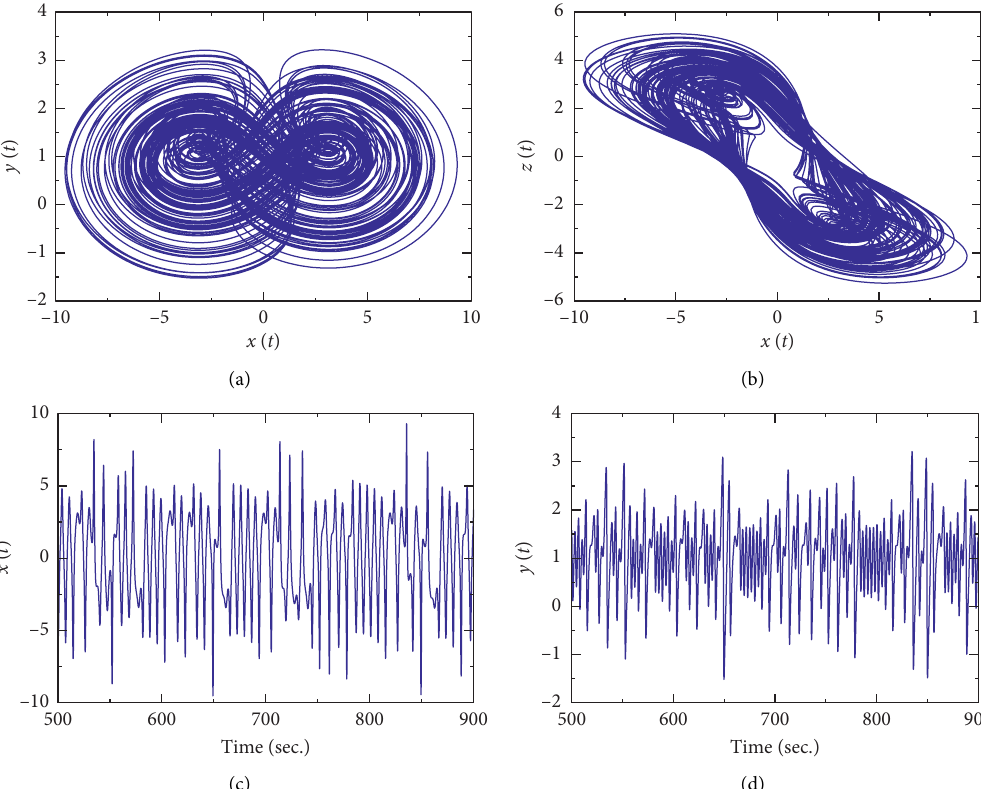
Figure 1: Phase diagrams and time series of system (5). (a) Projected onto the x − y phase plane. (b) Projected onto the x − z phase plane. (c) Time series of x . (d) Time series of y